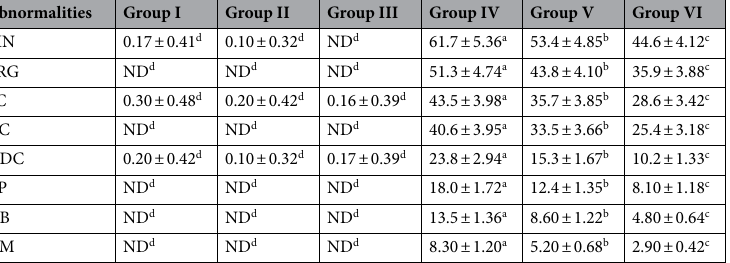
Table 2. Protective role of GSE against KBrO 3 -induced genotoxicity. Group I: Control, Group II: 465 mg/L GSE, Group III: 930 mg/L GSE, Group IV: 100 mg/L KBrO 3 , Group V: 100 mg/L KBrO 3 + 465 mg/L GSE, Group VI: 100 mg/L KBrO 3 + 930 mg/L GSE. Values are shown as mean ± SD (n = 10). The MN and CAs numbers were calculated by analyzing 1.000 cells in each group. The averages shown with different letters (a-d) in the same line are significant at p < 0.05. MI: mitotic index, MN: micronucleus, FRG: fragment, SC: sticky chromosome, VC: vagrant chromosome, UDC: unequal distribution of chromatin, RP: reverse polarization, NB: nuclear bud, DM: disordered mitosis, ND: no